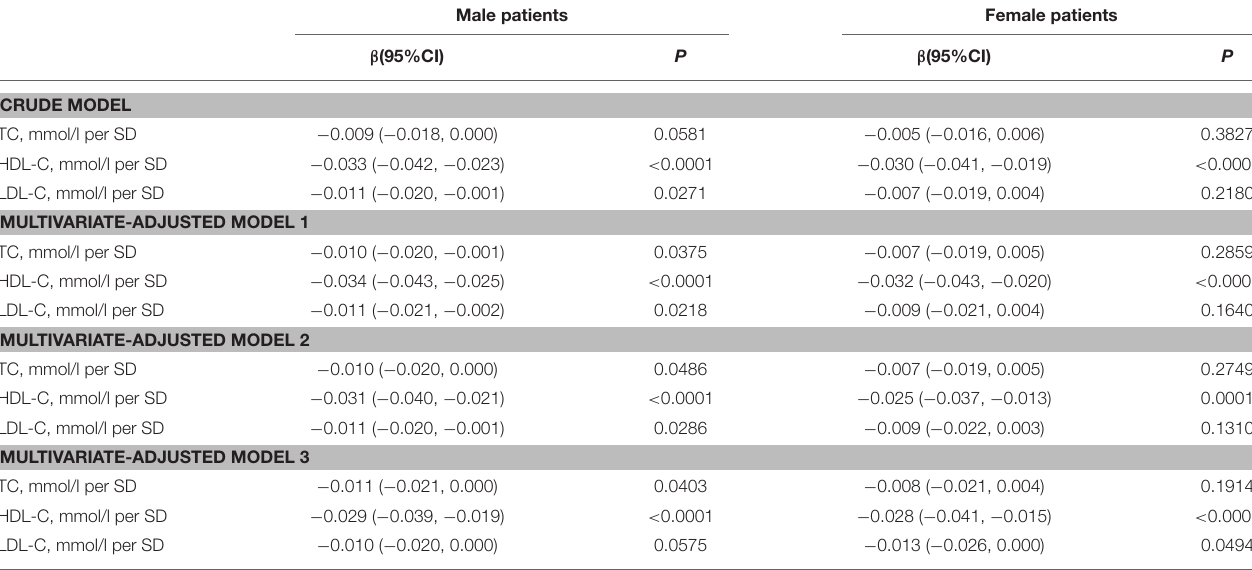
TABLE 4 | Multivariate Regression for Effect of TC, HDL-C, and LDL-C on total hip BMD.